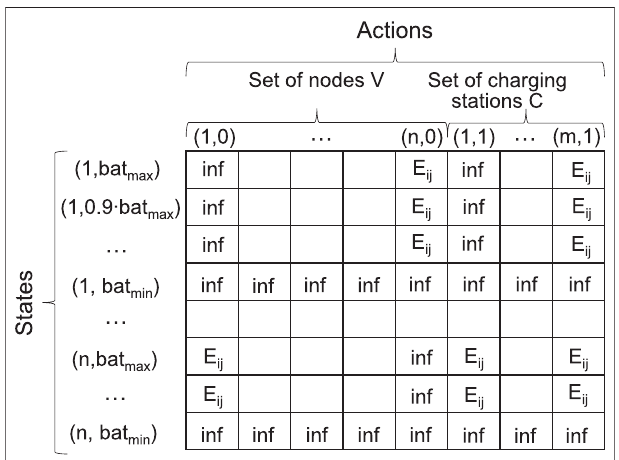
FIGURE 1 | Matrix representation of a combined state-action